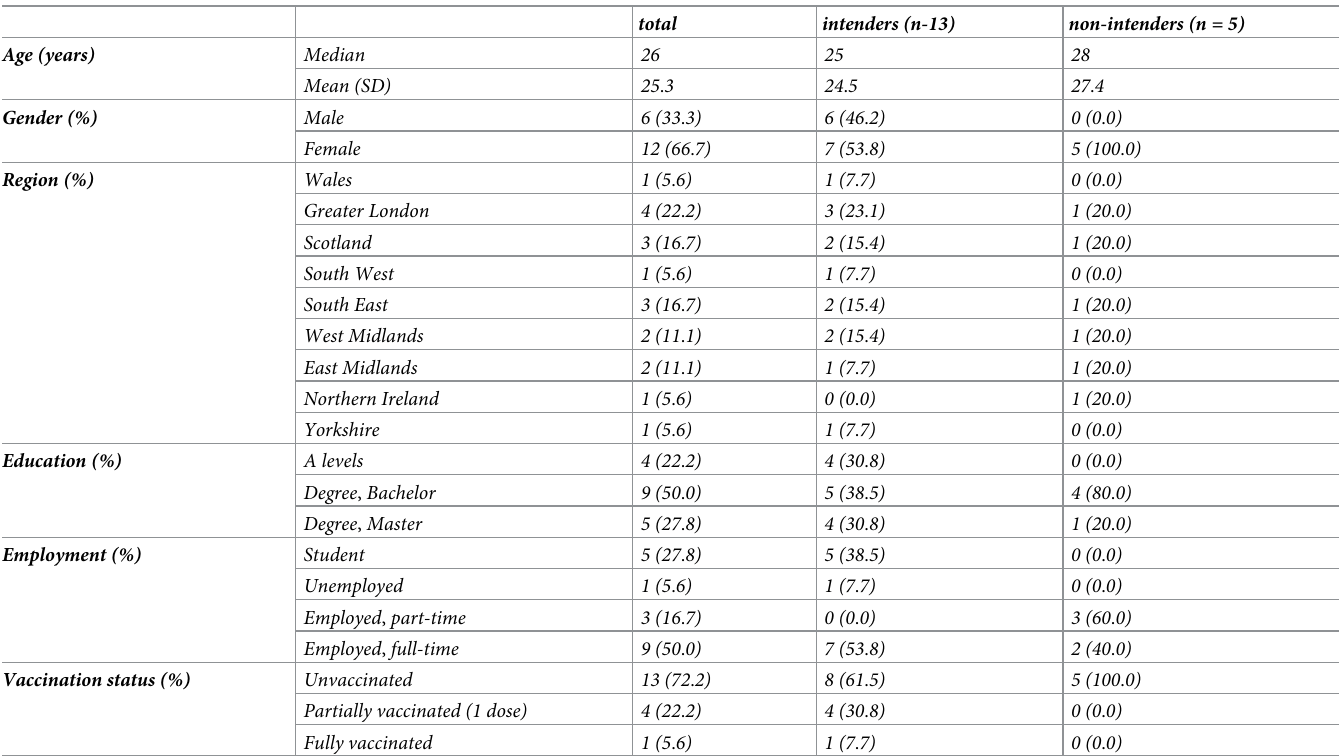
Table 1. Summary of demographic